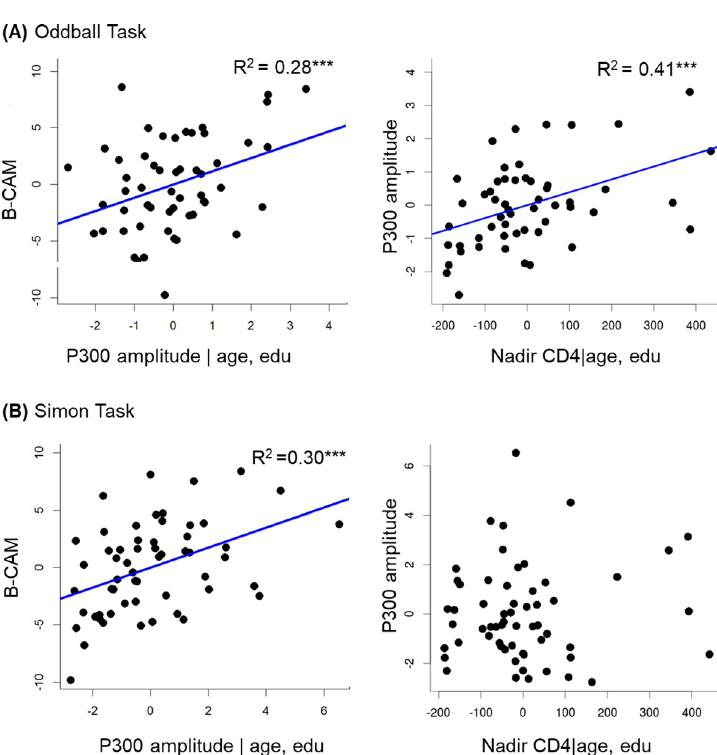
Fig 4. Partial regression plots of the relationship of P300 amplitudes evoked by (A) oddball and (B) Simon tasks with cognitive ability (B-CAM score) and immunocompromise (nadir CD4 cell count), controlling for the effects of age and education. ��� p <